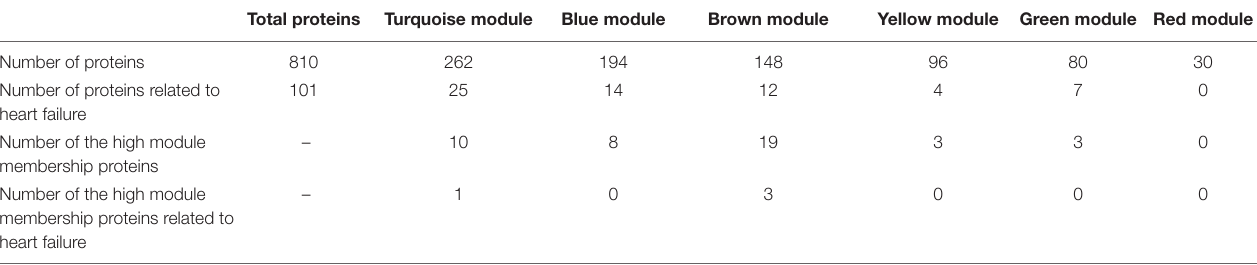
TABLE 1 | The number of proteins in WGCNA modules in the in vitro dataset. Total proteins Turquoise module Blue module Brown module Yellow module Green module Red